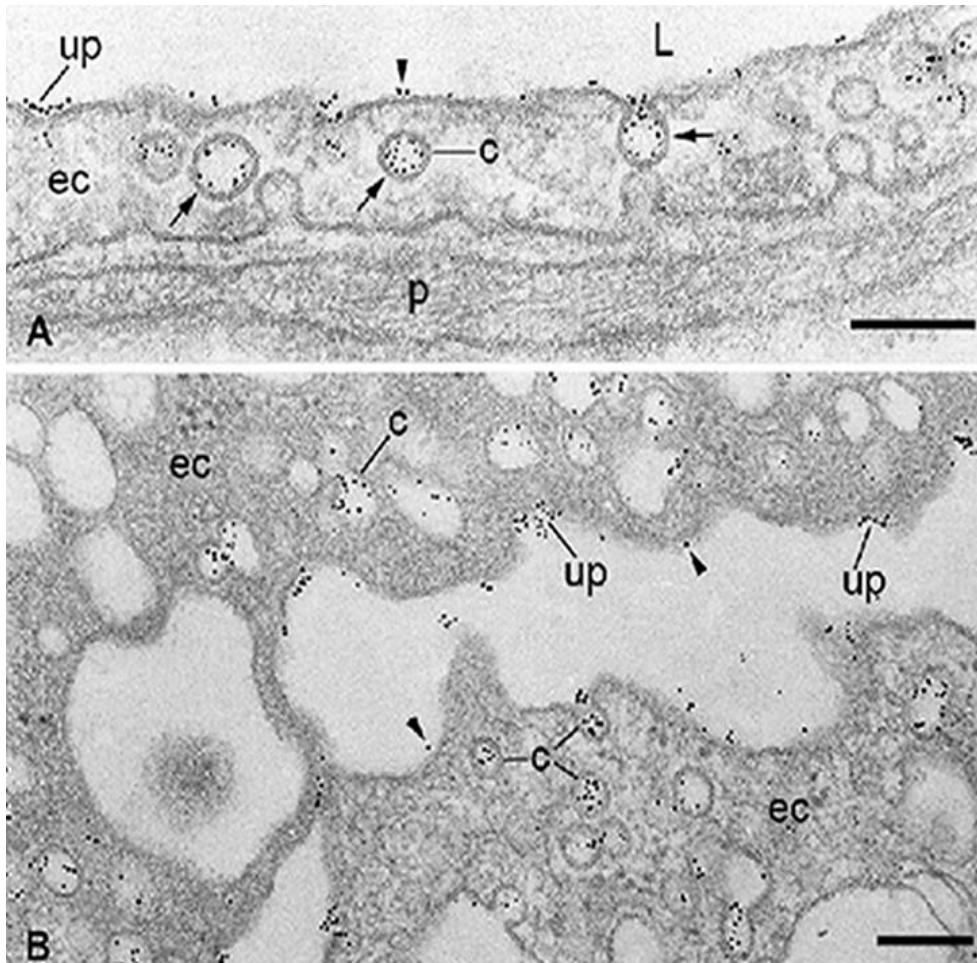
Figure 2. Localization at the electron microscope level of specific binding-sites for albumin associated with the capillary endothelium in healthy adipose tissue ( A ) and microvascular endothelial cells (ECs) freshly isolated from rat epididymal fat ( B ). The binding of bovine serum albumin (BSA)-Au5 nm conjugate is restricted to the membrane of caveolae (c), predominantly in an adsorptive pattern (arrows) and some uncoated pits (up). Some particles of BSA-Au5 nm conjugate rarely appear on plasma membrane proper (arrowhead). ec, endothelial cell; L, capillary lumen; p, pericyte. The scale bar represents 200 nm in both panels. Adapted with permission from ref. [62]. Copyright 1988 Journal of Cell Biology.